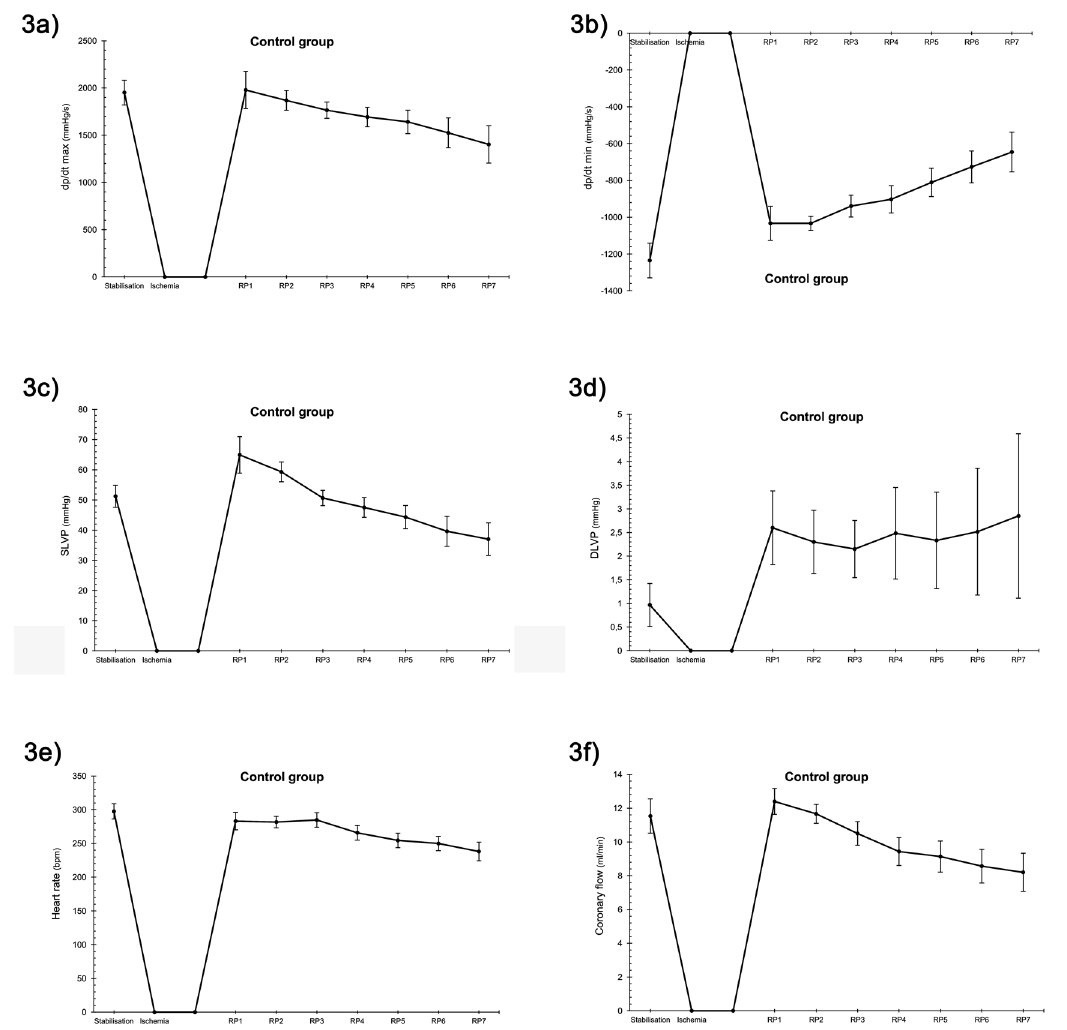
Fig. 3 - The influence of ishemia (20 minutes)/reperfusion (30 minutes) on cardiodynamic parameters of the isolated rat heart: 3a) dp/dtmax, 3b) dp/dtmin, 3c) SLVP, 3d) DLVP, 3e) HR, 3f)